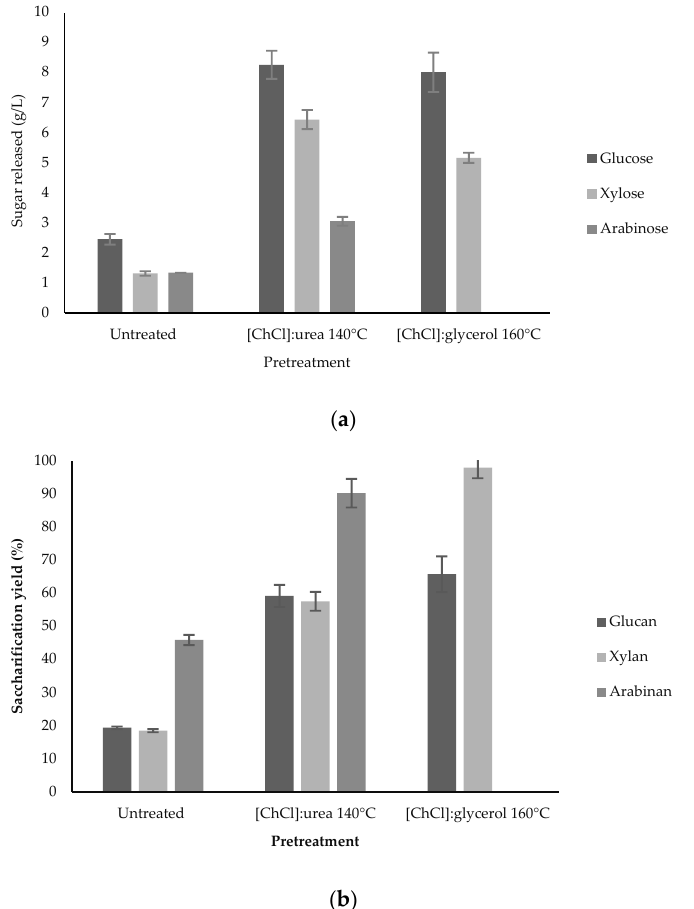
Figure 2. Released sugars ( a ) and saccharification yield ( b ) obtained after enzymatic hydrolysis carried out in BSG untreated and pretreated with different eutectic mixtures. Table 3. Saccharification yields using DES pretreatment on lignocellulosic biomass.